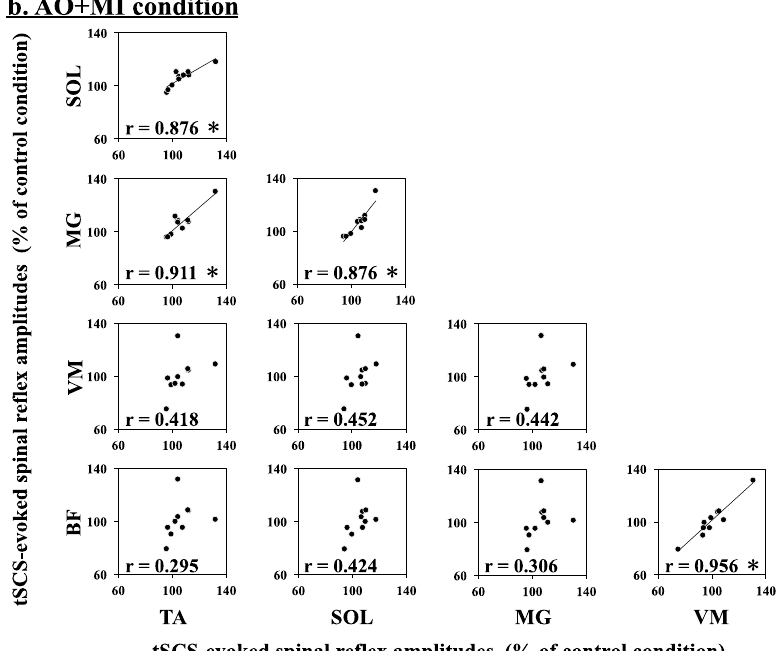
Figure 4. Pearson correlation of simultaneous modulation patterns of transcutaneous spinal cord stimulation (tSCS)-evoked spinal reflexes in di ff erent lower-limb muscles during action observation (AO; open circles; ( a )) and AO with motor imagery (AO + MI; closed circles; ( b )) conditions. Each plot indicates the mean tSCS-evoked spinal reflexes (% of control) in each muscle from all participants. The r values indicate Pearson’s correlation coe ffi cients. * Significant correlation between two lower-limb muscles ( p <